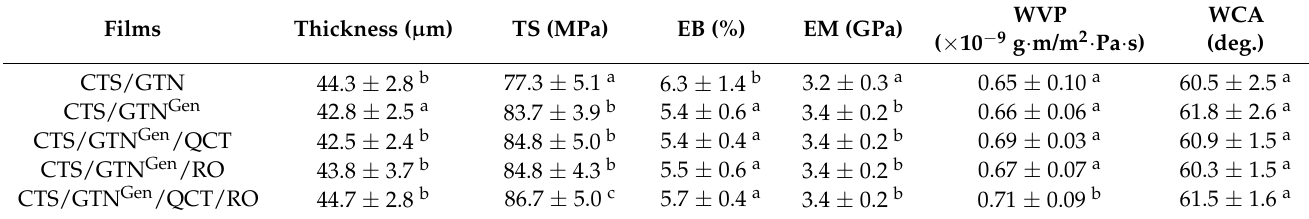
Table 2. The mechanical properties, water vapor permeability, and water contact angle of the chitosan/gelatin-based